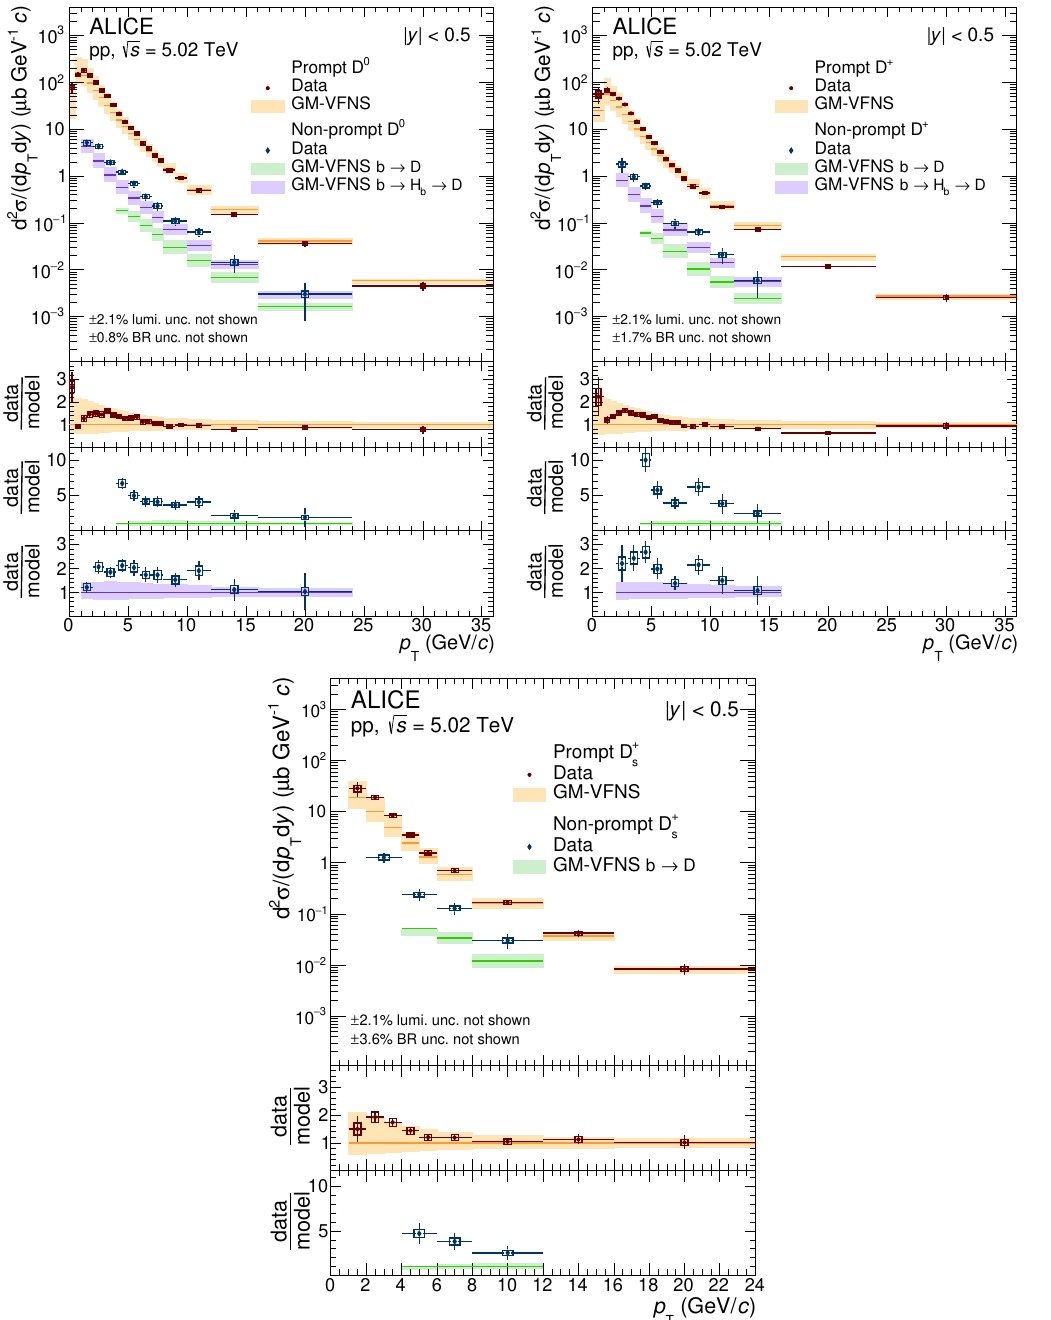
Figure 8 . p T -differential production cross sections of prompt and non-prompt D 0 (top left panel), D + (top right panel), and D + (bottom panel) mesons compared to predictions obtained with GM- s VFNS calculations [60, 61, 63]. For the non-prompt D 0 and D + mesons the one-step (green) and two-step (purple) approaches, describing the transition from the beauty quark to the charm meson, are reported. The measurement of prompt D 0 mesons is the one reported in ref. [3], with updated decay BR as discussed in the